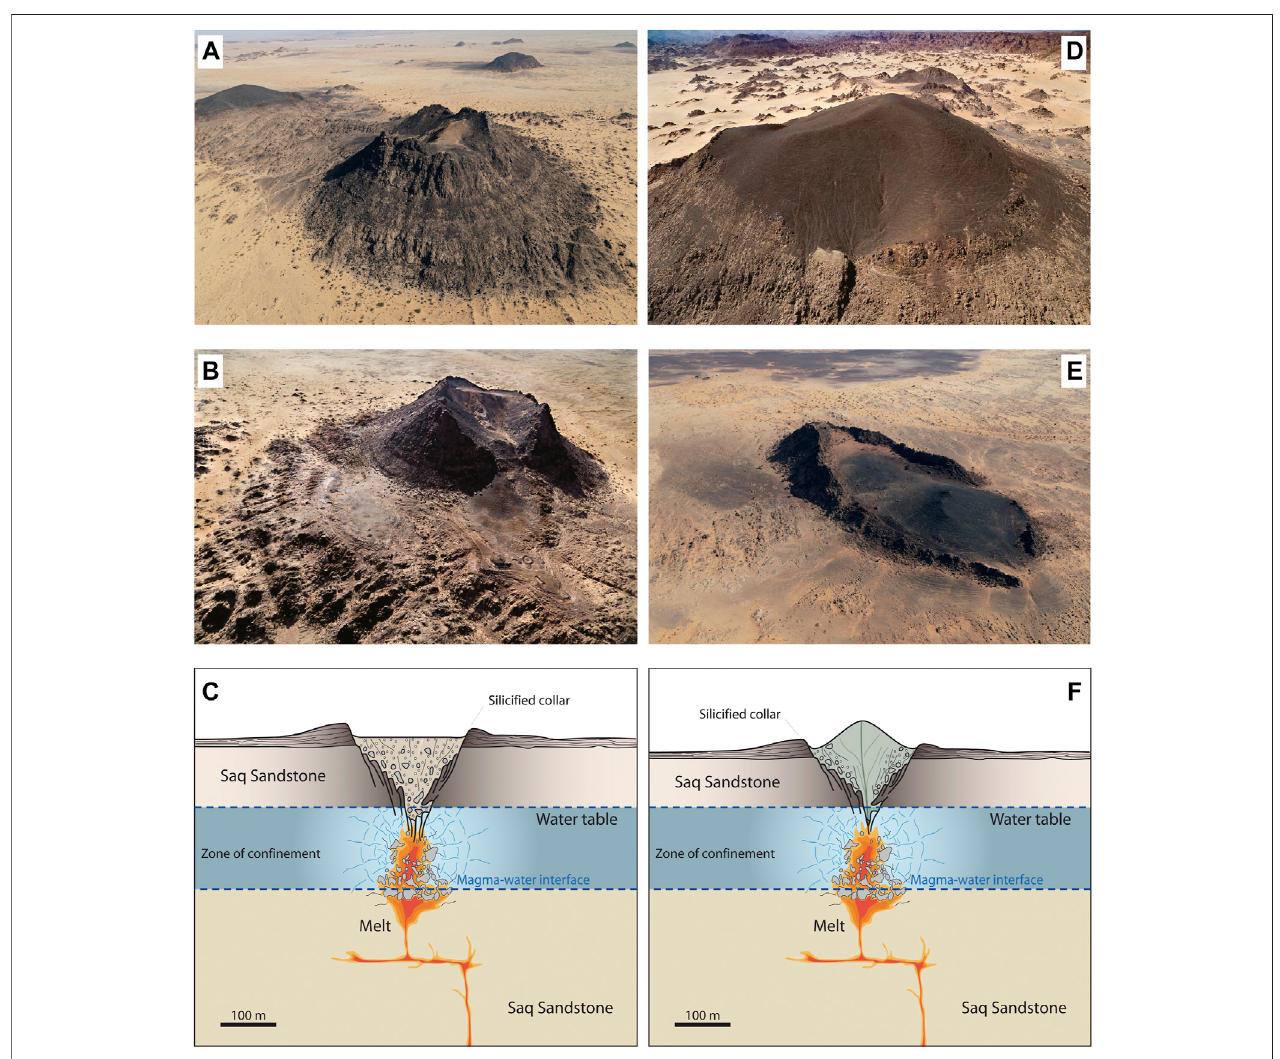
FIGURE3| AerialviewoftheMarthoumvolcanicpipeswithout (A , B) andwith (D , E) intra-cratercolumnar-jointedbasaltsurroundedbyacollarofsilici fi edPaleozoic sandstone.Location ofpipes in (A, B,D,E) isshown in Figure 1 .UH-10samplesarefrom thepipe shown in (D) . (C , F) cartoons showing pipeformationmechanismby generalized sections through the main pipe/crater types identi fi